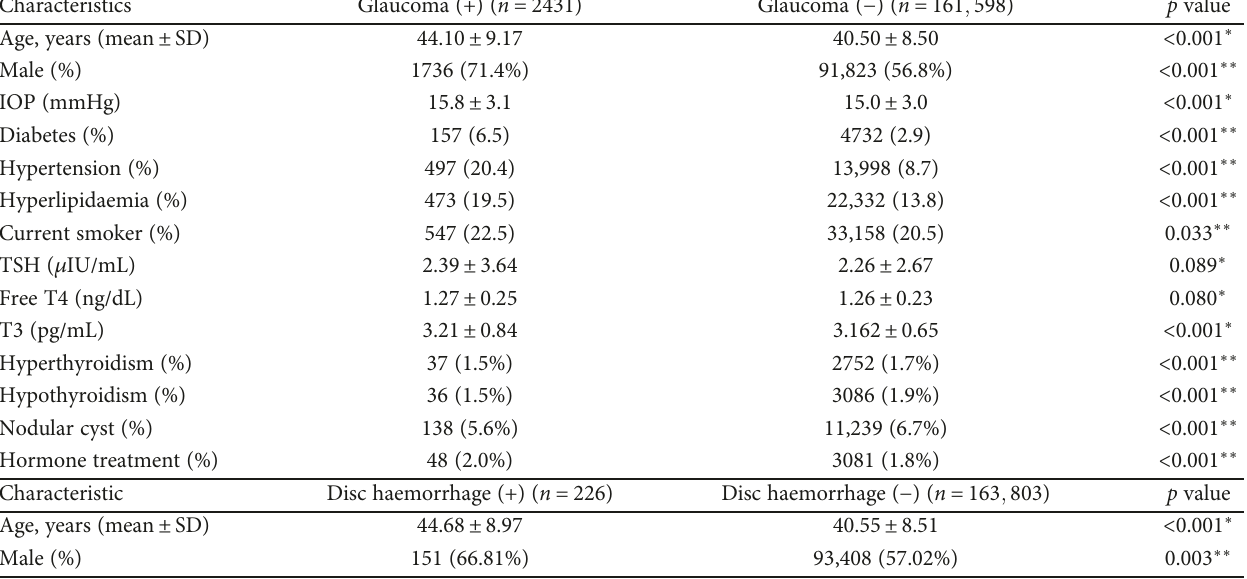
Table 1: Demographic and general health